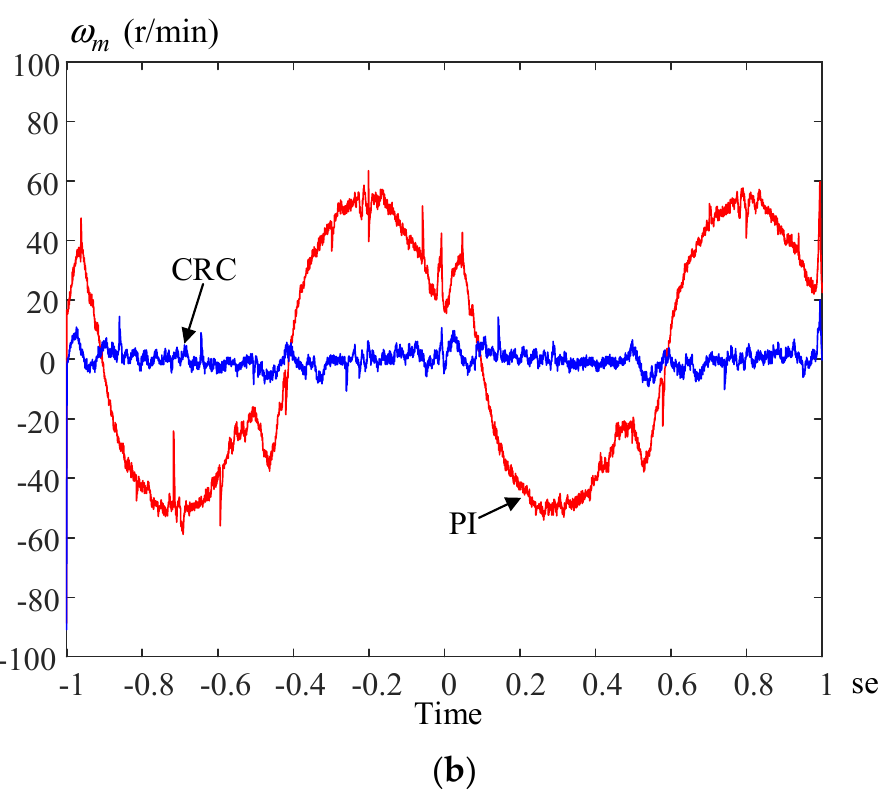
Figure 13. The measured sinusoidal speed responses: ( a ) responses; ( b ) tracking errors.